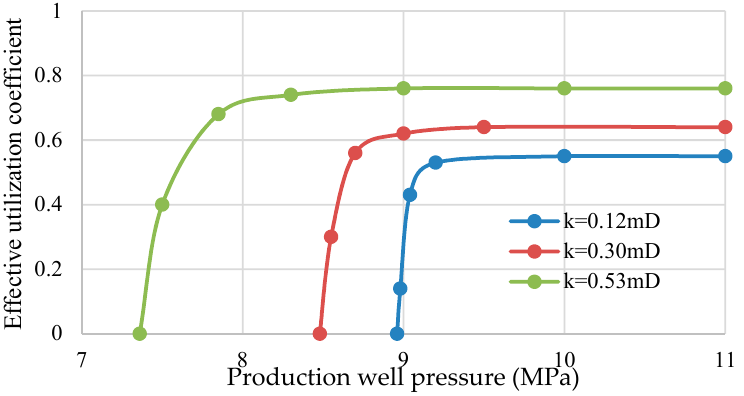
Figure 16. The relationship between the effective utilization coefficient and the production well pressure before fracturing.